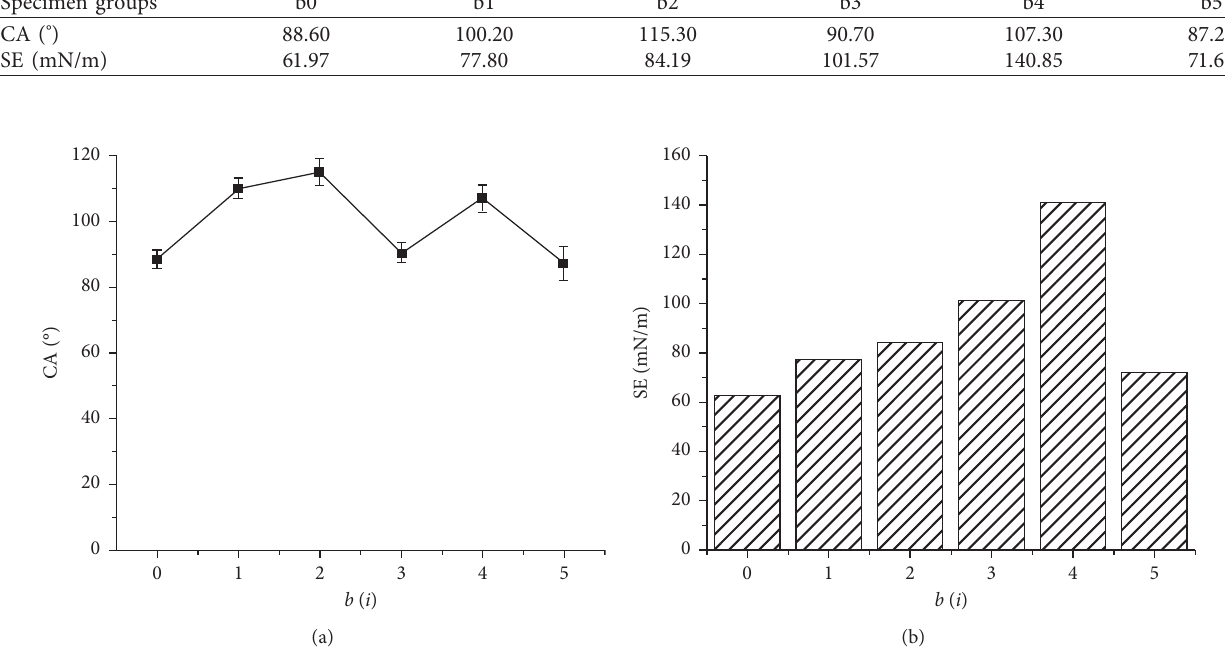
Figure 15: (a) Measured contact angles and (b) calculated surface energies (b) of FC specimens containing increasingly higher amounts of